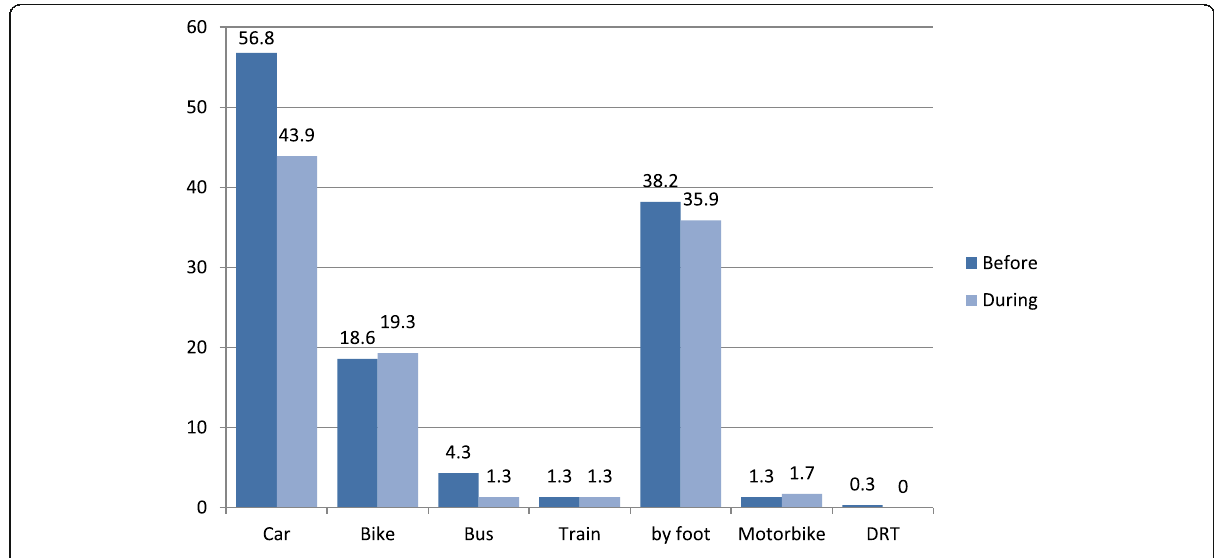
Fig. 2 Share of daily usage according to means of